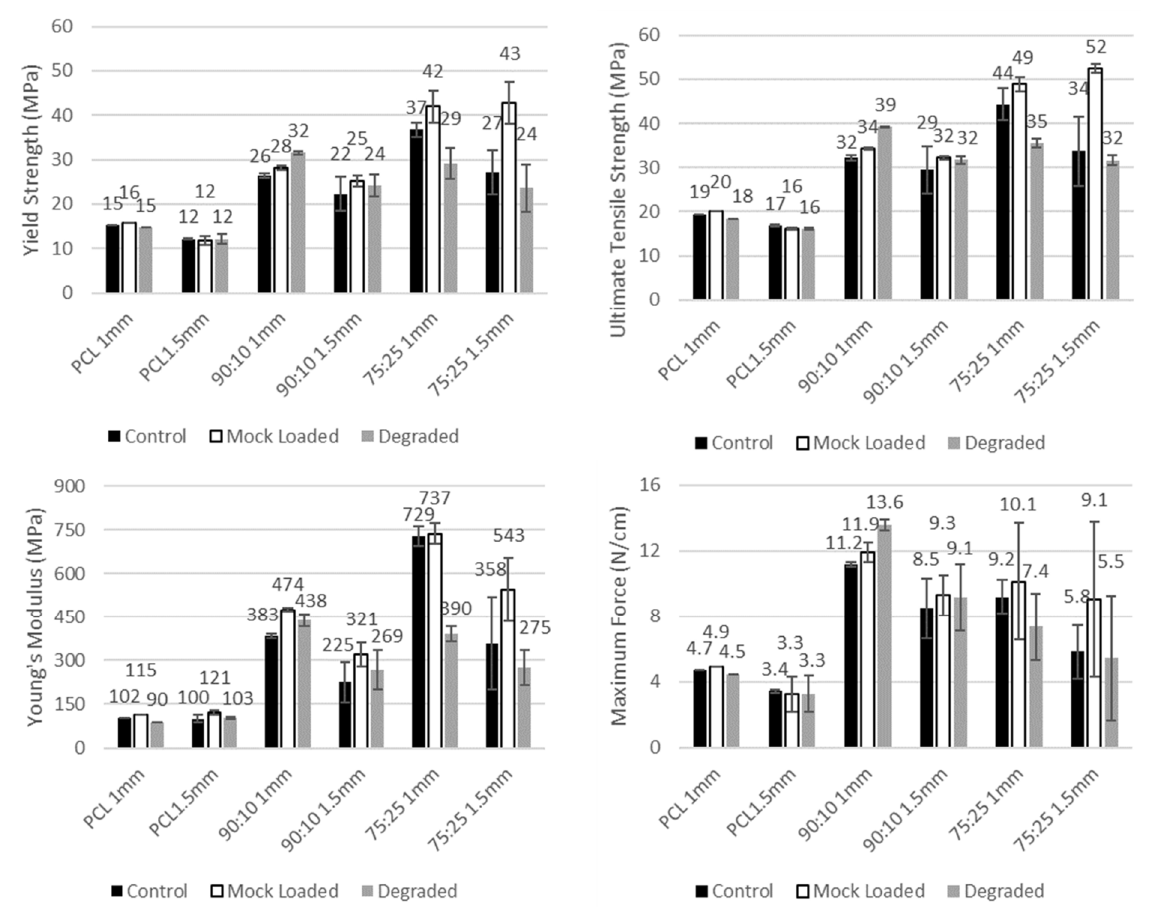
Figure 3. Tensile testing results, including strength (yield strength ( top left ), ultimate tensile strength ( top right ) and max force per centimetre ( bottom right )) and stiffness (Young’s modulus ( bottom left )) measures for each grouping. Results are given in mean with error bar denoting standard deviation.